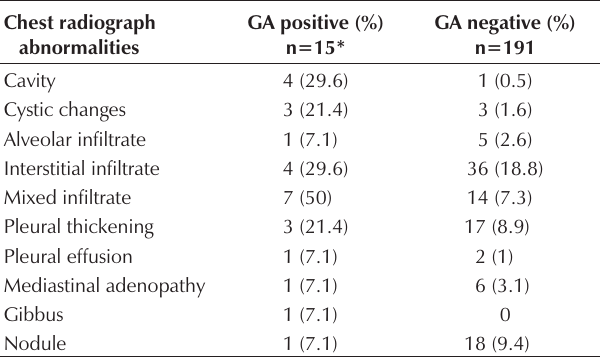
Correlation of chest radiograph findings and results of gastric aspirate (GA) culture